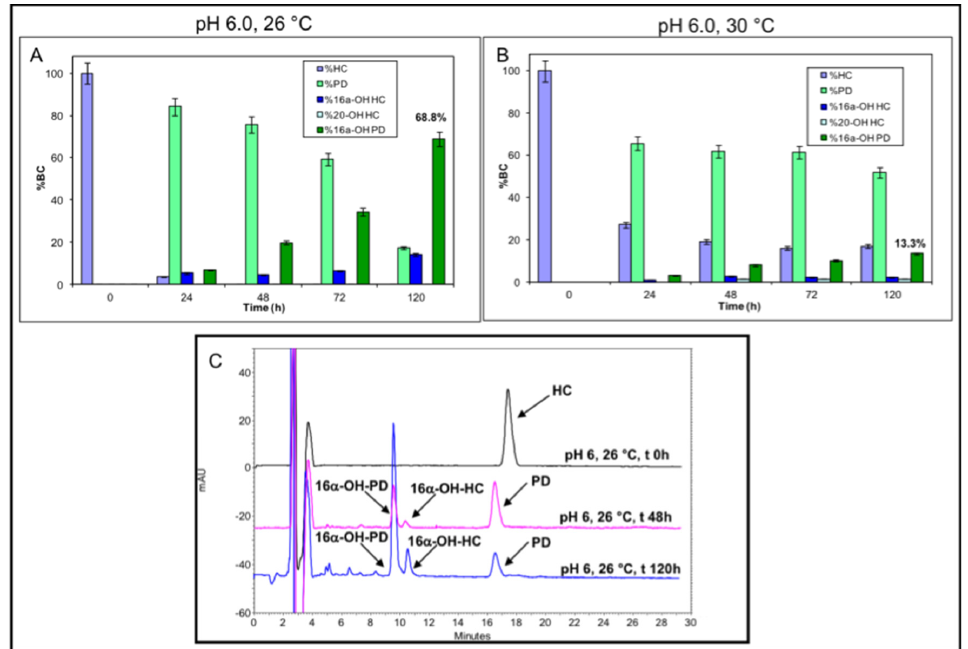
Figure 6. Bioconversion of 0.1 g·L − 1 HC into different products in whole cell experiments at pH 6.0 and at 26 or 30 °C, obtained by coupling A. simplex and S. roseochromogenes , respectively ( A , B ). In the graphs, the obtained 16 α -OH-prednisolone percentages are reported in bold. Overlaid HPLC chromatograms of the 0.1 g·L − 1 HC bioconversion samples at pH 6.0 and 26 °C at different time points ( C ) (0 h, black line; 48 h, pink line; 120 h, blue line). All peaks are indicated by arrows.